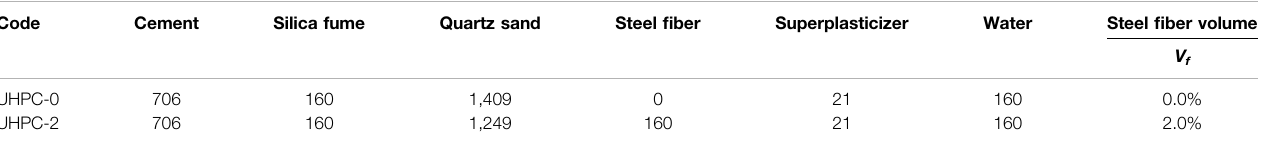
TABLE 1 | Mix proportion (kg/m 3 ).